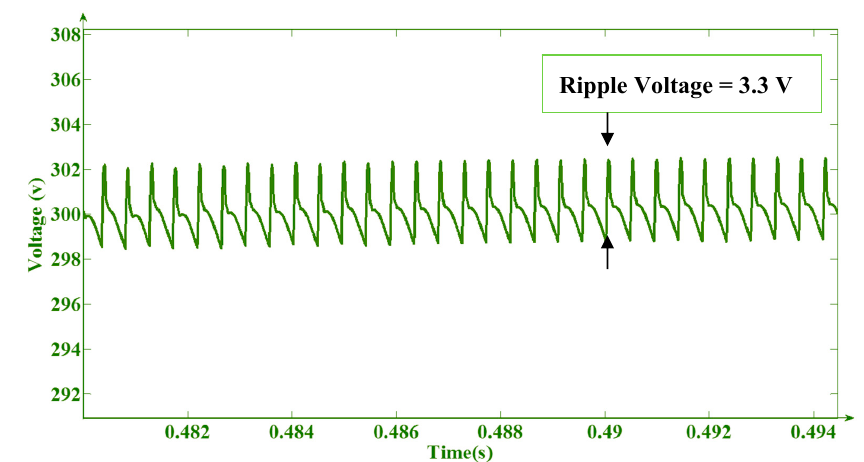
Electronics 2019 , 8 , 1092 Figure 44. Ripple voltage waveform for hybrid controller-1. Figure 44. Ripple voltage waveform for hybrid controller-1.